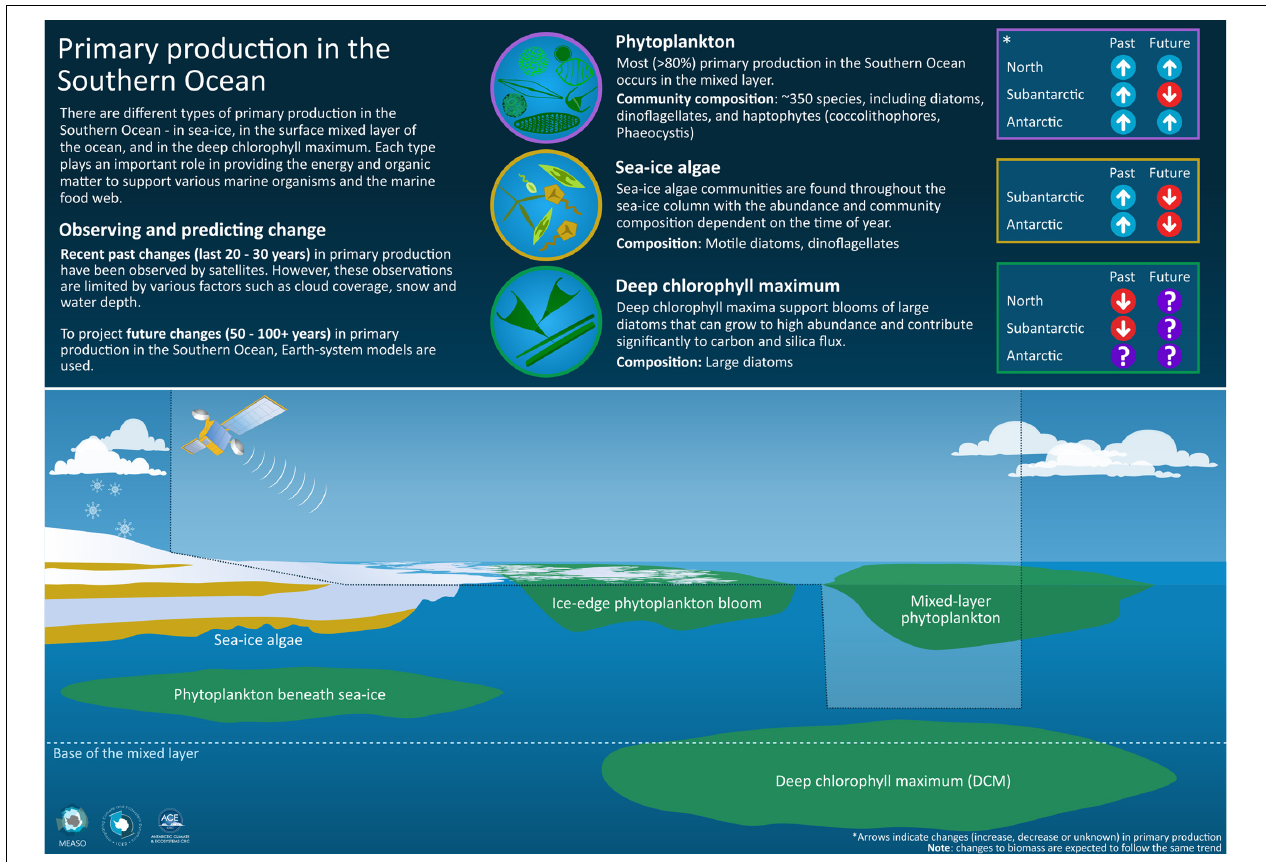
FIGURE 7 | There are different types of primary production in the Southern Ocean – in sea ice, in the surface mixed-layer of the ocean, and in the deep chlorophyll maximum (DCM). Only some of these types of primary production can be observed by satellite over the last 20–30 years. Earth-system models can project future changes to primary production in the next 50–100 years. Changes vary between the Northern, Subantarctic and Antarctic zones.